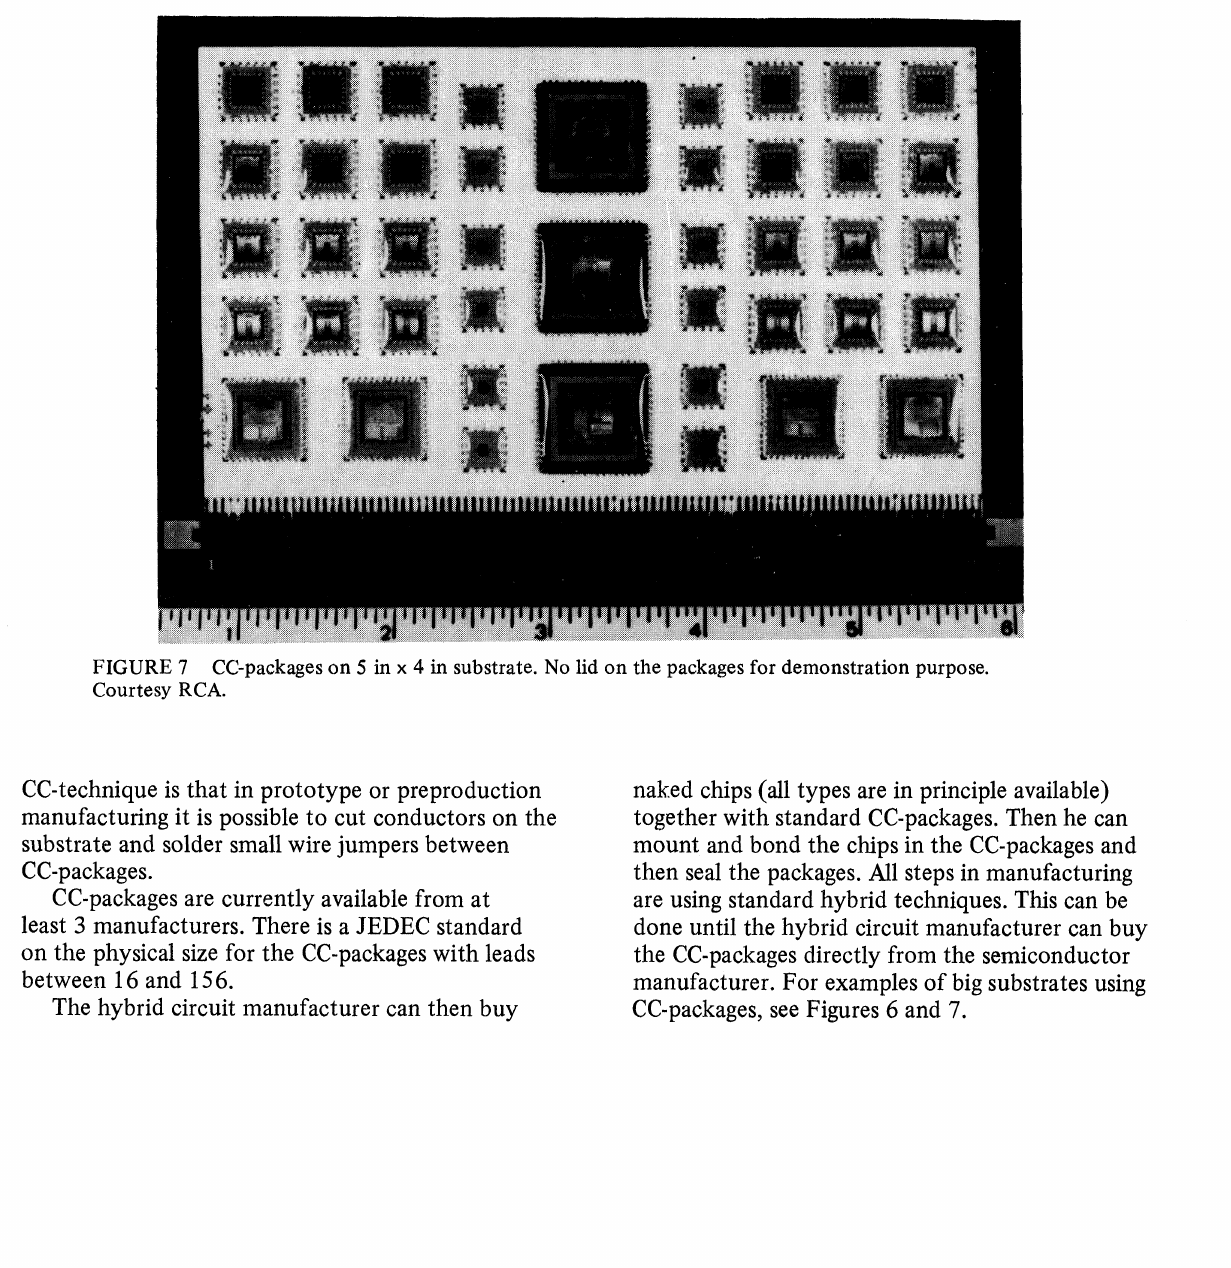
FIGURE 6 Chip Carriers in NAFI module. Courtesy Texas Instruments.